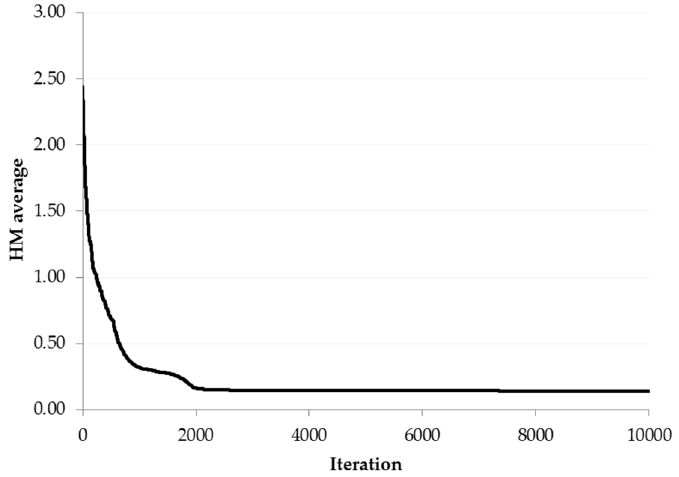
Figure 10. The performance of the HM (40 harmonies) with respect to iterations of the optimization function for the EV1-3P of hydrometric station 10031.